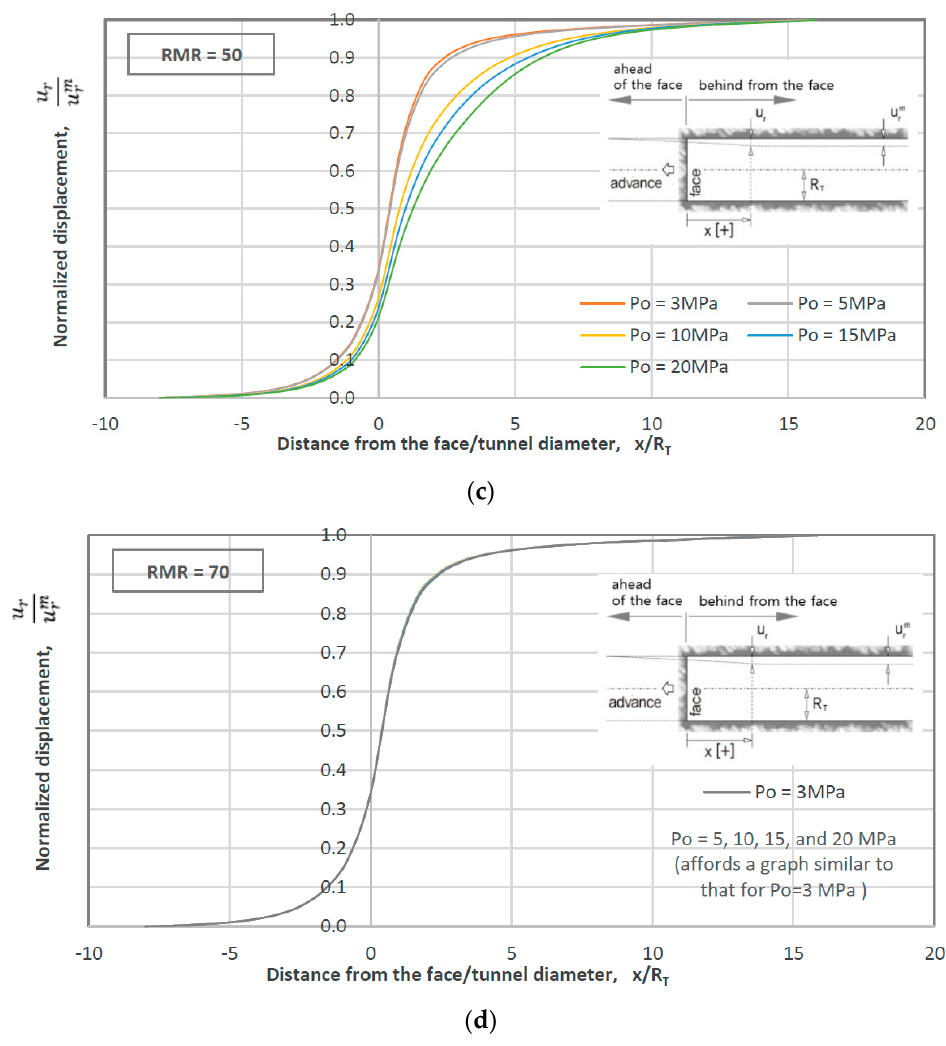
Figure 8. Variation of LDP with initial stress conditions: ( a ) RMR = 10; ( b ) RMR = 30; ( c ) RMR = 50; and ( d ) RMR = 70.